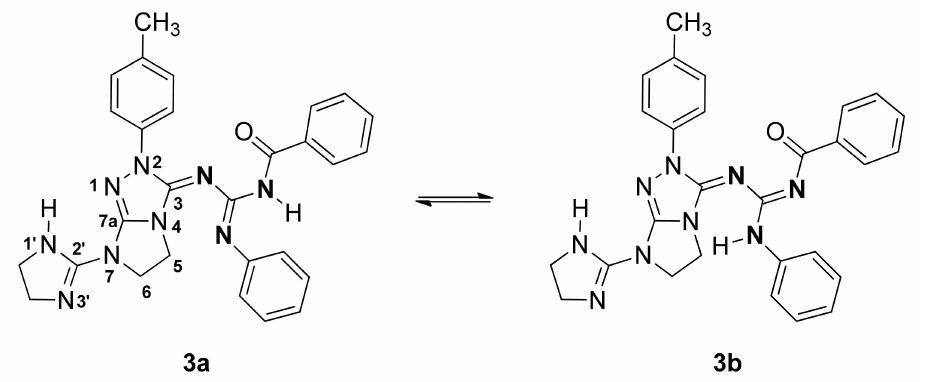
Figure 2. Tautomers 3a and 3b